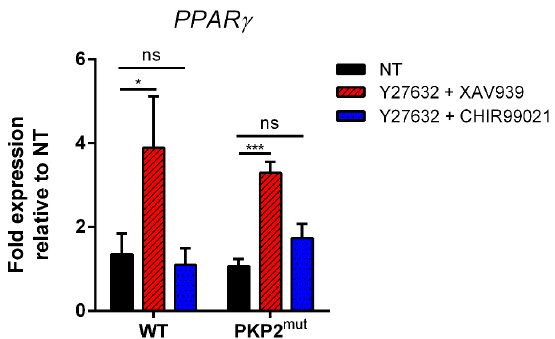
Figure 7. qRT–PCR analysis of PPAR γ expression in WT and PKP2 mut CMs after 12 days of Wnt/ β - catenin and RhoA-ROCK pathways modulation. Treatment with 30 µ M Y27632 (Rock inhibitor) in combination with 10 µ M XAV939 (Wnt inhibitor) leads to a significant overexpression of PPAR γ respect to untreated CMs (red striped bars); treatment with 3 µ M CHIR99021 (Wnt activator) in combination with Y27632 restored the expression of PPAR γ to levels almost equal to untreated cells in WT group, while PKP2 mut CMs do not undergo to a complete PPAR γ downregulation (blue dotted bars); n = 3; * p < 0.05, *** p < 0.001; t -test. Data are shown as means ± SEM; NT = not